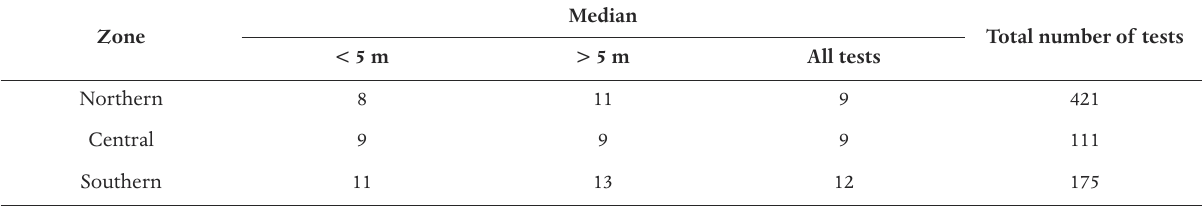
values (N < 50) in the anthropogenic deposits at different depths for the three Table 1. Median of N SPT SPT